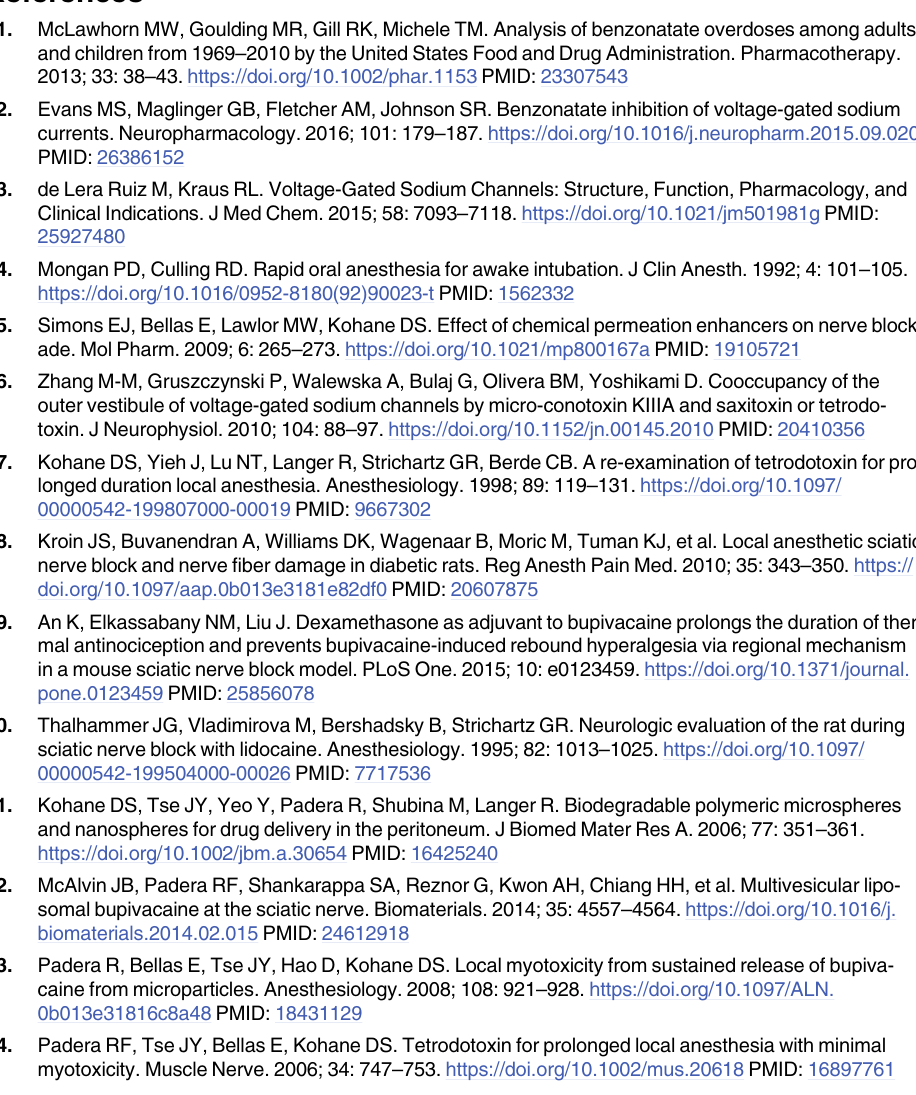
S2 Table. Tissue toxicity of benzonatate: Inflammation and myotoxicity